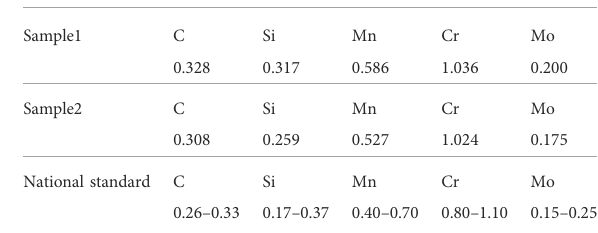
TABLE 1 Chemical composition of